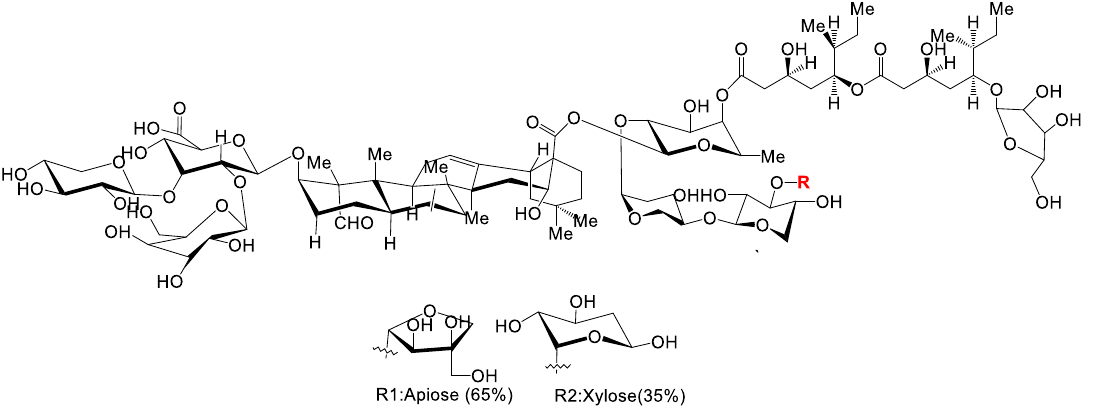
Figure 9. QS-21 adjuvant